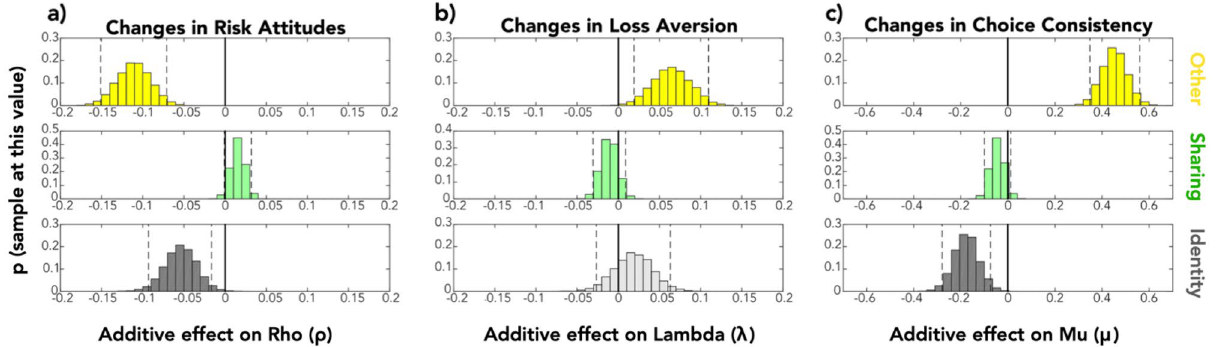
Figure 3. Changes in risky decision computations as a function of social context. Hierarchical Bayesian Estimation of changes in decision-makers’ risk attitudes ( a ), loss aversion ( b ) and choice consistency ( c ) due to social factors revealed consistent additive effects of: (1) ‘other’ on all three computations; and (2) ‘identity’ on risk attitudes and choice consistency. 95% highest density intervals (HDIs) are denoted by dashed vertical lines. No consistent additive effects of ‘sharing’ on any decision computations were observed at the 95% HDI level. Each histogram depicts the distribution of 10,000 samples of that parameter from Model 1. Distributions of samples whose 95% HDI excluded zero are presented in saturated colors, while those for which the 95% HDI included zero are depicted in pale